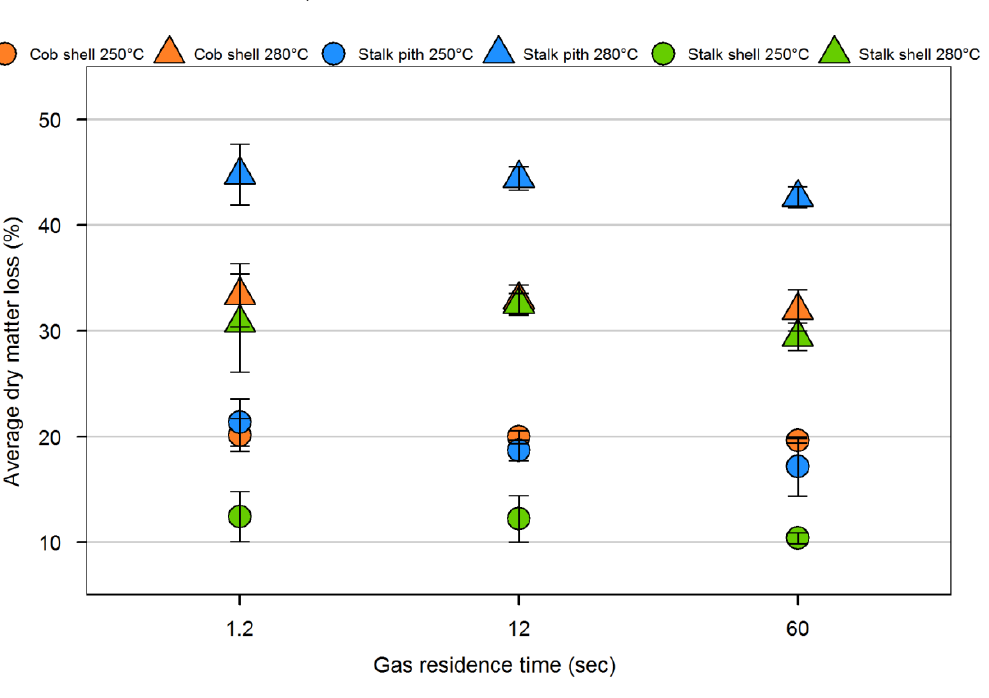
Figure 6. Average dry matter loss of torrefied stalk shell, stalk pith, and cob shell (error bar = standard